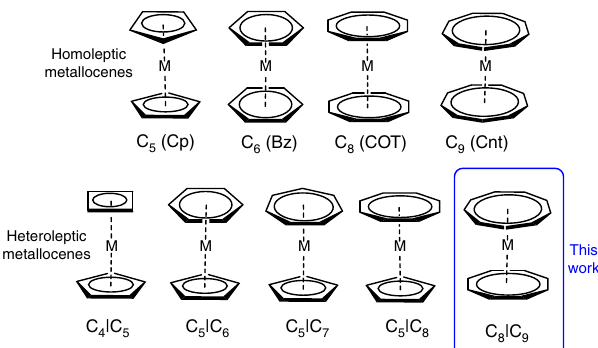
Fig. 1 Examples of sandwich complexes. Structurally characterized homoleptic and heteroleptic metallocenes with C x ring systems (x = 4 –